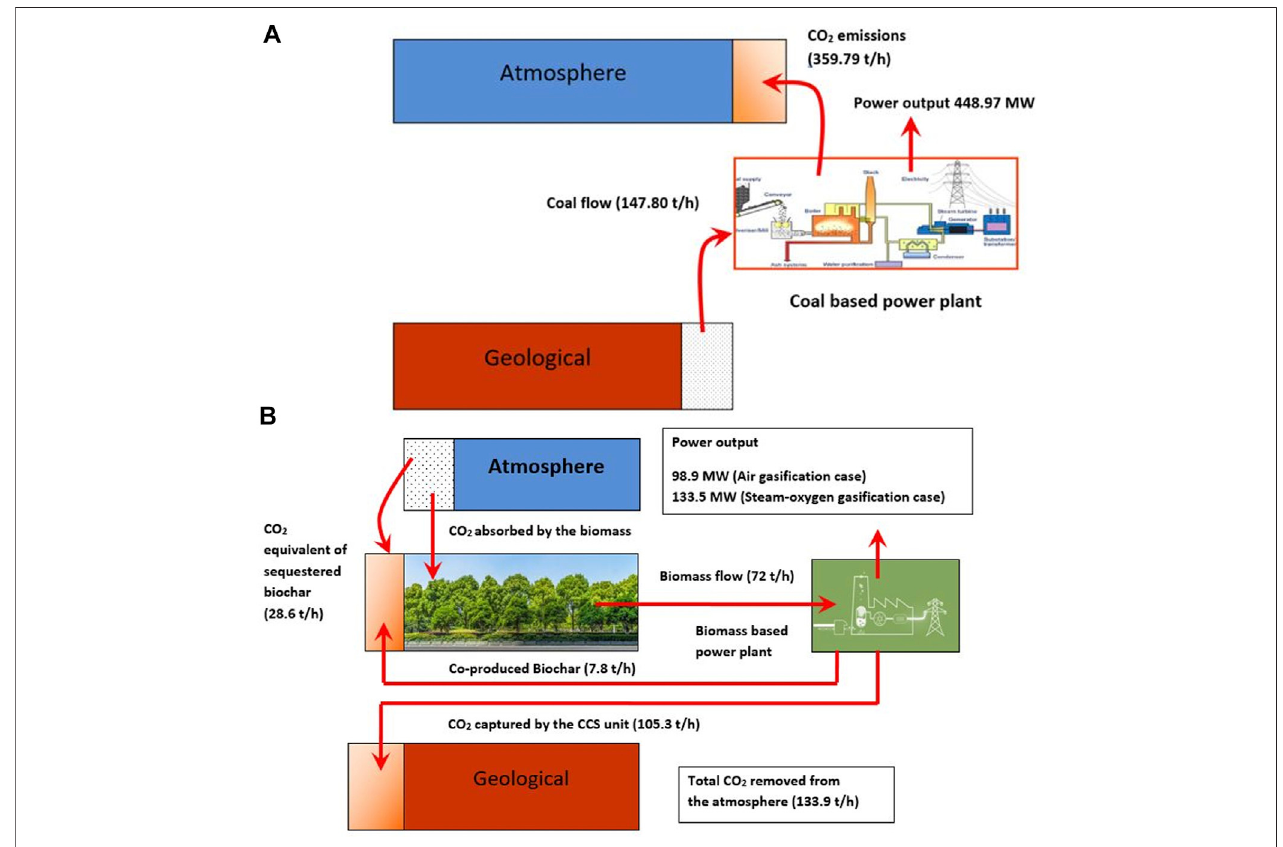
FIGURE 8 | (A) Main CO 2 fl ows in a typical coal-based power plant. (B) Main CO 2 fl ows in the BECCS including biochar addition to soil for the 10% biochar co- production in the given biomass feed.